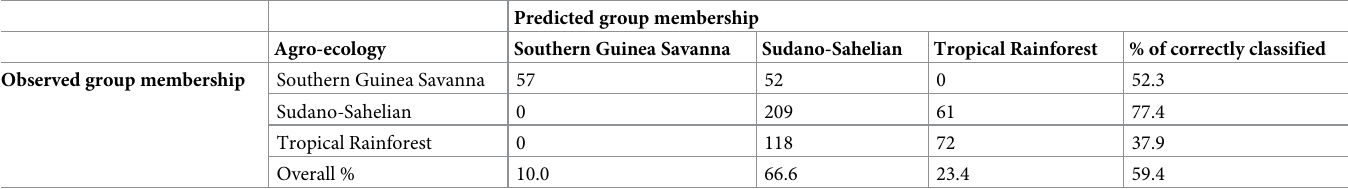
Table 10. The classification matrix of birds in the three agro-ecological zones based on Exhaustive CHAID